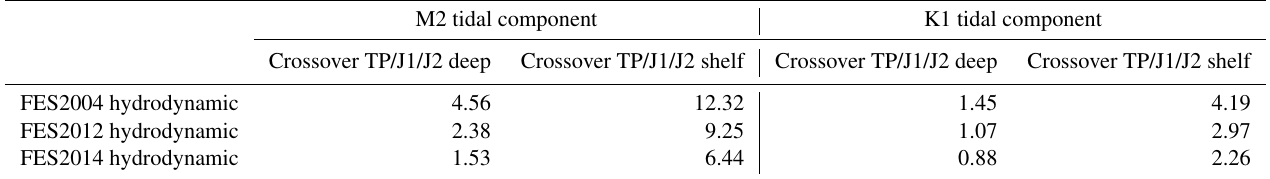
Table 1. The rms of the vector differences (in cm) between the purely hydrodynamic solutions of FES2004, FES2012, and FES2014, and the TP/J1/J2 altimeter crossover points, for the M2 and K1 tidal components. The accuracy improvement between the FES2012 and FES2014 prior solutions is a key ingredient in the accuracy improvement between the FES2012 and FES2014a/b/c assimilated